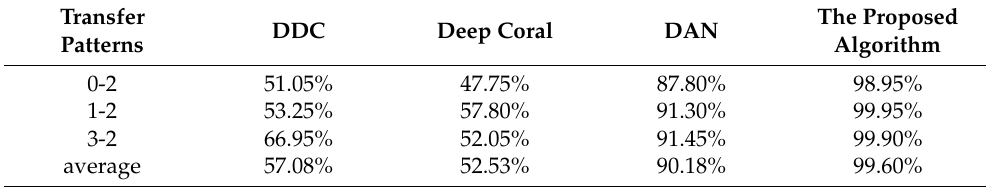
Table 3. Experimental results with imbalanced data.